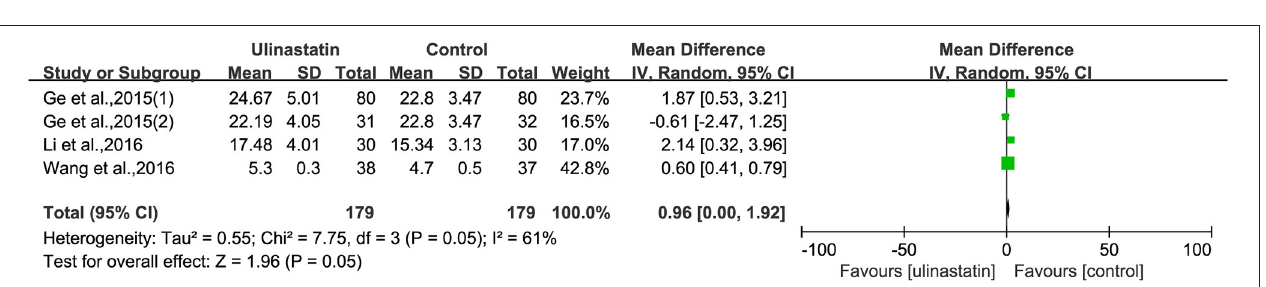
FIGURE 10 | Forest plot: Comparing plasma interleukin (IL)-10 of patients receiving ulinastatin vs. control.